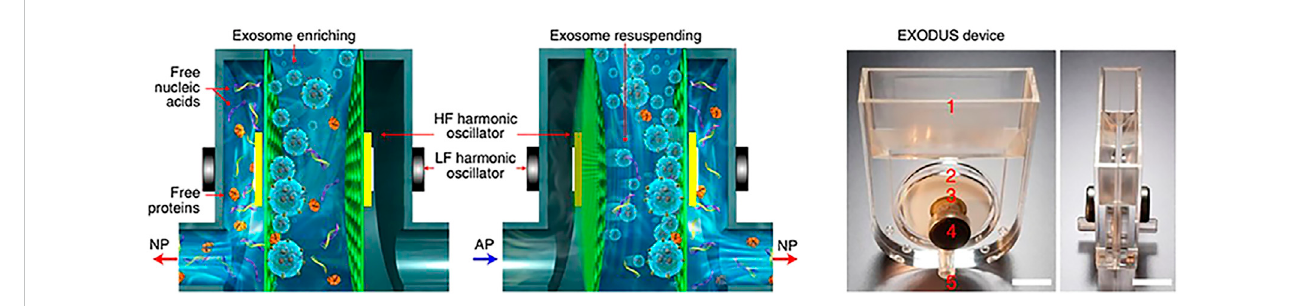
FIGURE 4 The mechanism of NPO and the schematic diagram of the EXODUS device. Exosomes can be isolated ultra-rapidly using negative pressure oscillations and double-coupled harmonic oscillator membrane vibrations. Reproduced with permission from (Chen et al.,